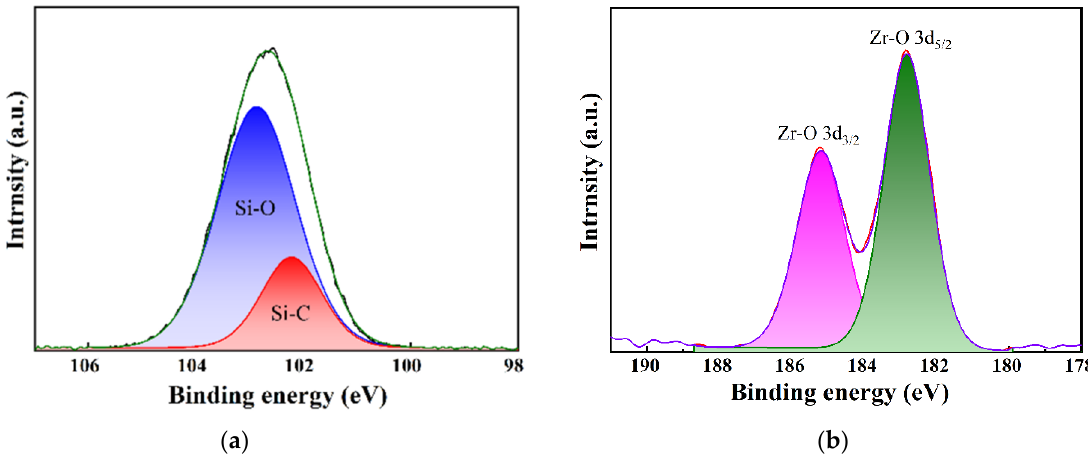
Figure 6. XPS peak decomposition for the ( a ) Si 2p and ( b ) Zr 3d photoelectron peaks of the ZrO 2 - MSiO 2 materials.